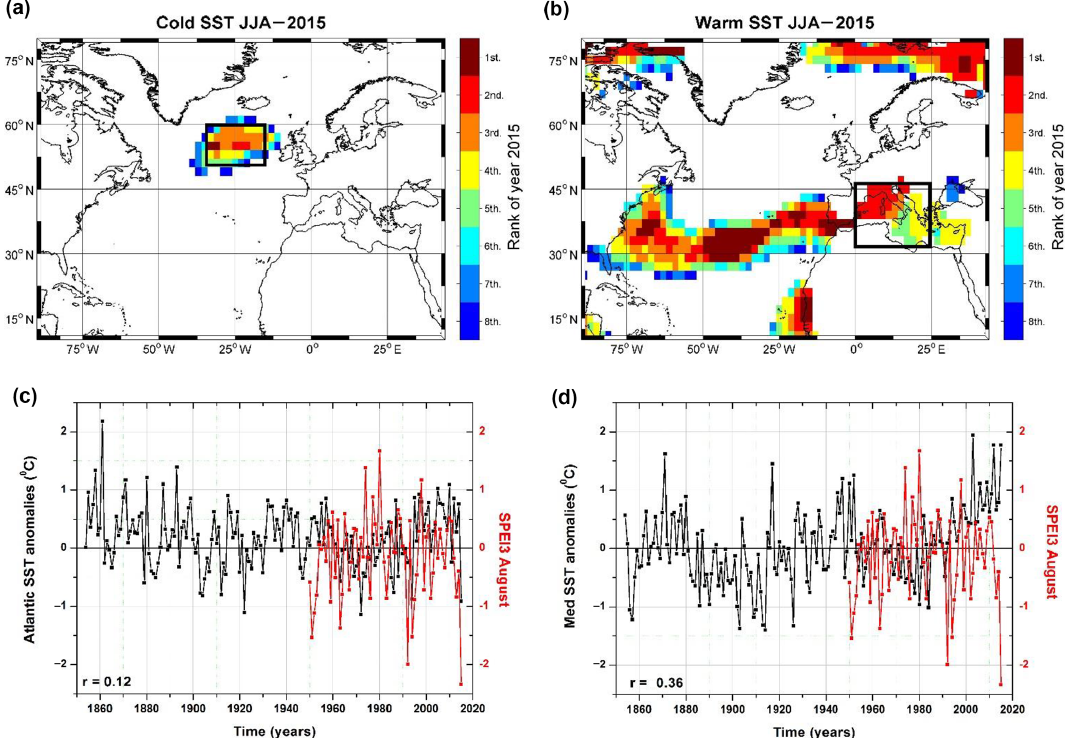
Figure 11. (a) Top-eight ranking of 2015 summer (JJA) cold SST. (b) Top-eight ranking of 2015 summer (JJA) warm SST. (c) The time series of JJA cold-SST index averaged over the black box in (a) (black line) and the time series of August SPEI3 index averaged over the black box in Fig. 7a (red line). (d) The time series of JJA warm-SST index averaged over the black box in (b) and the time series of August SPEI3 index averaged over the black box in Fig. 7a (red line). The Atlantic SST index and the Med SST index are based on the ERSSTv4b dataset (Liu et al., 2014). Analyzed period: